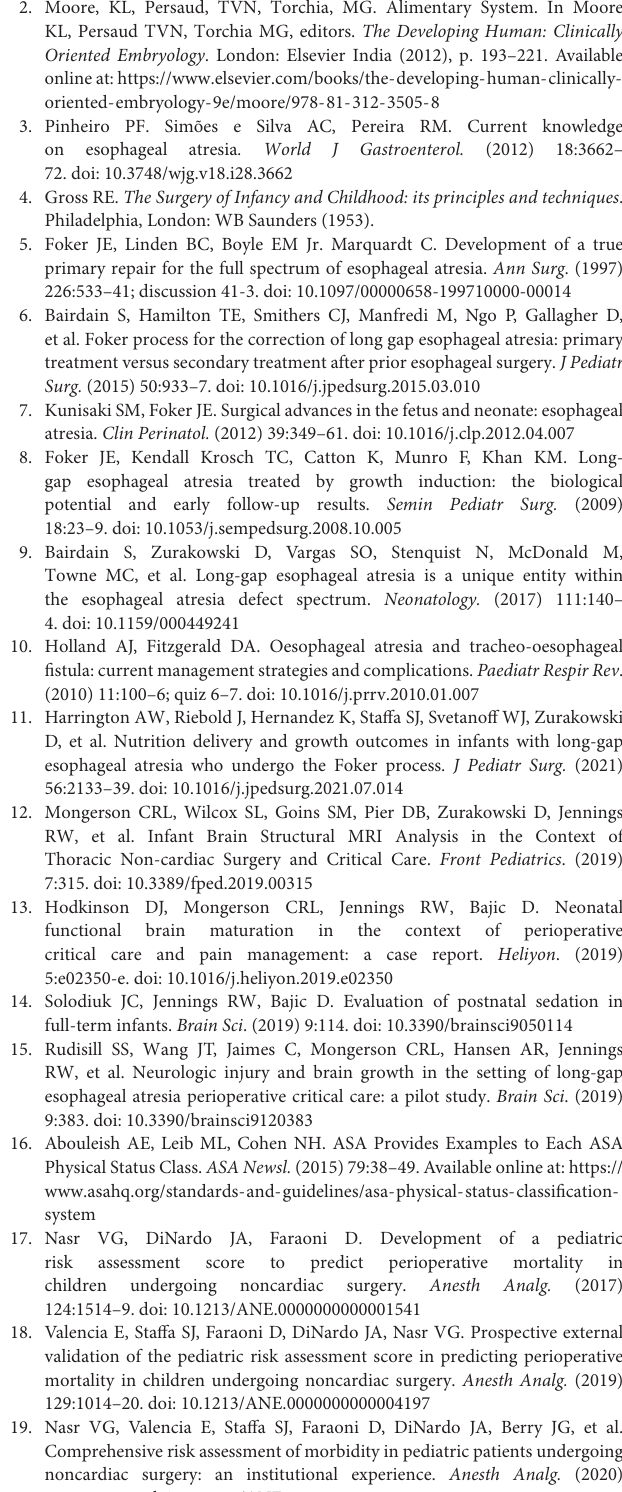
Frontiers in Surgery |